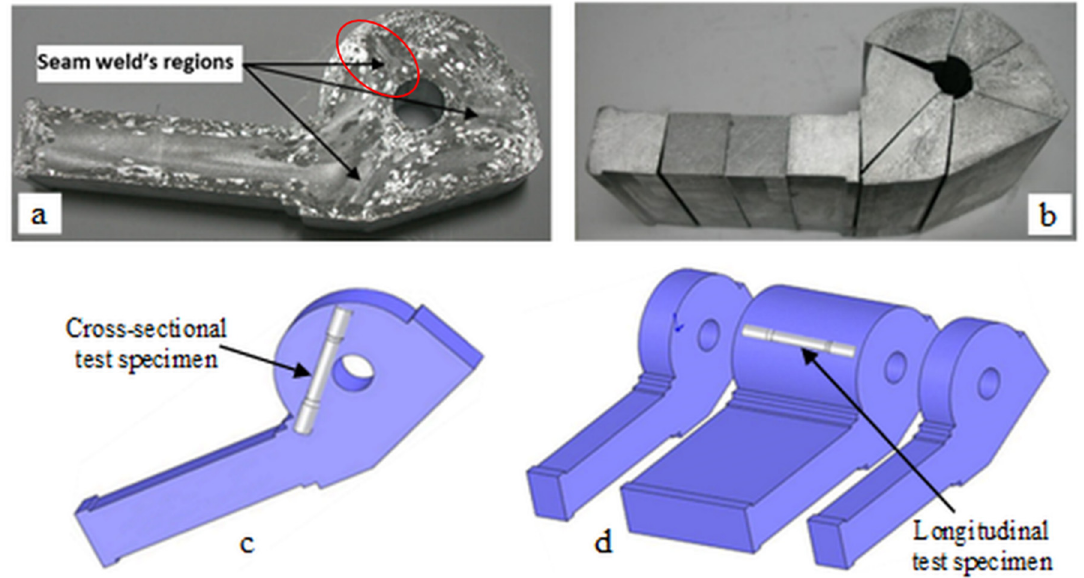
Figure 1. Preparing the seam welded tensile test specimens: ( a ) Macro etched specimen to detect seam welds; ( b ) Cutting the seam welded tensile specimens parallel to extrusion direction; ( c ) Illustration of the seam welded tensile specimen perpendicular to extrusion direction; ( d ) Illustration of the specimen parallel to extrusion